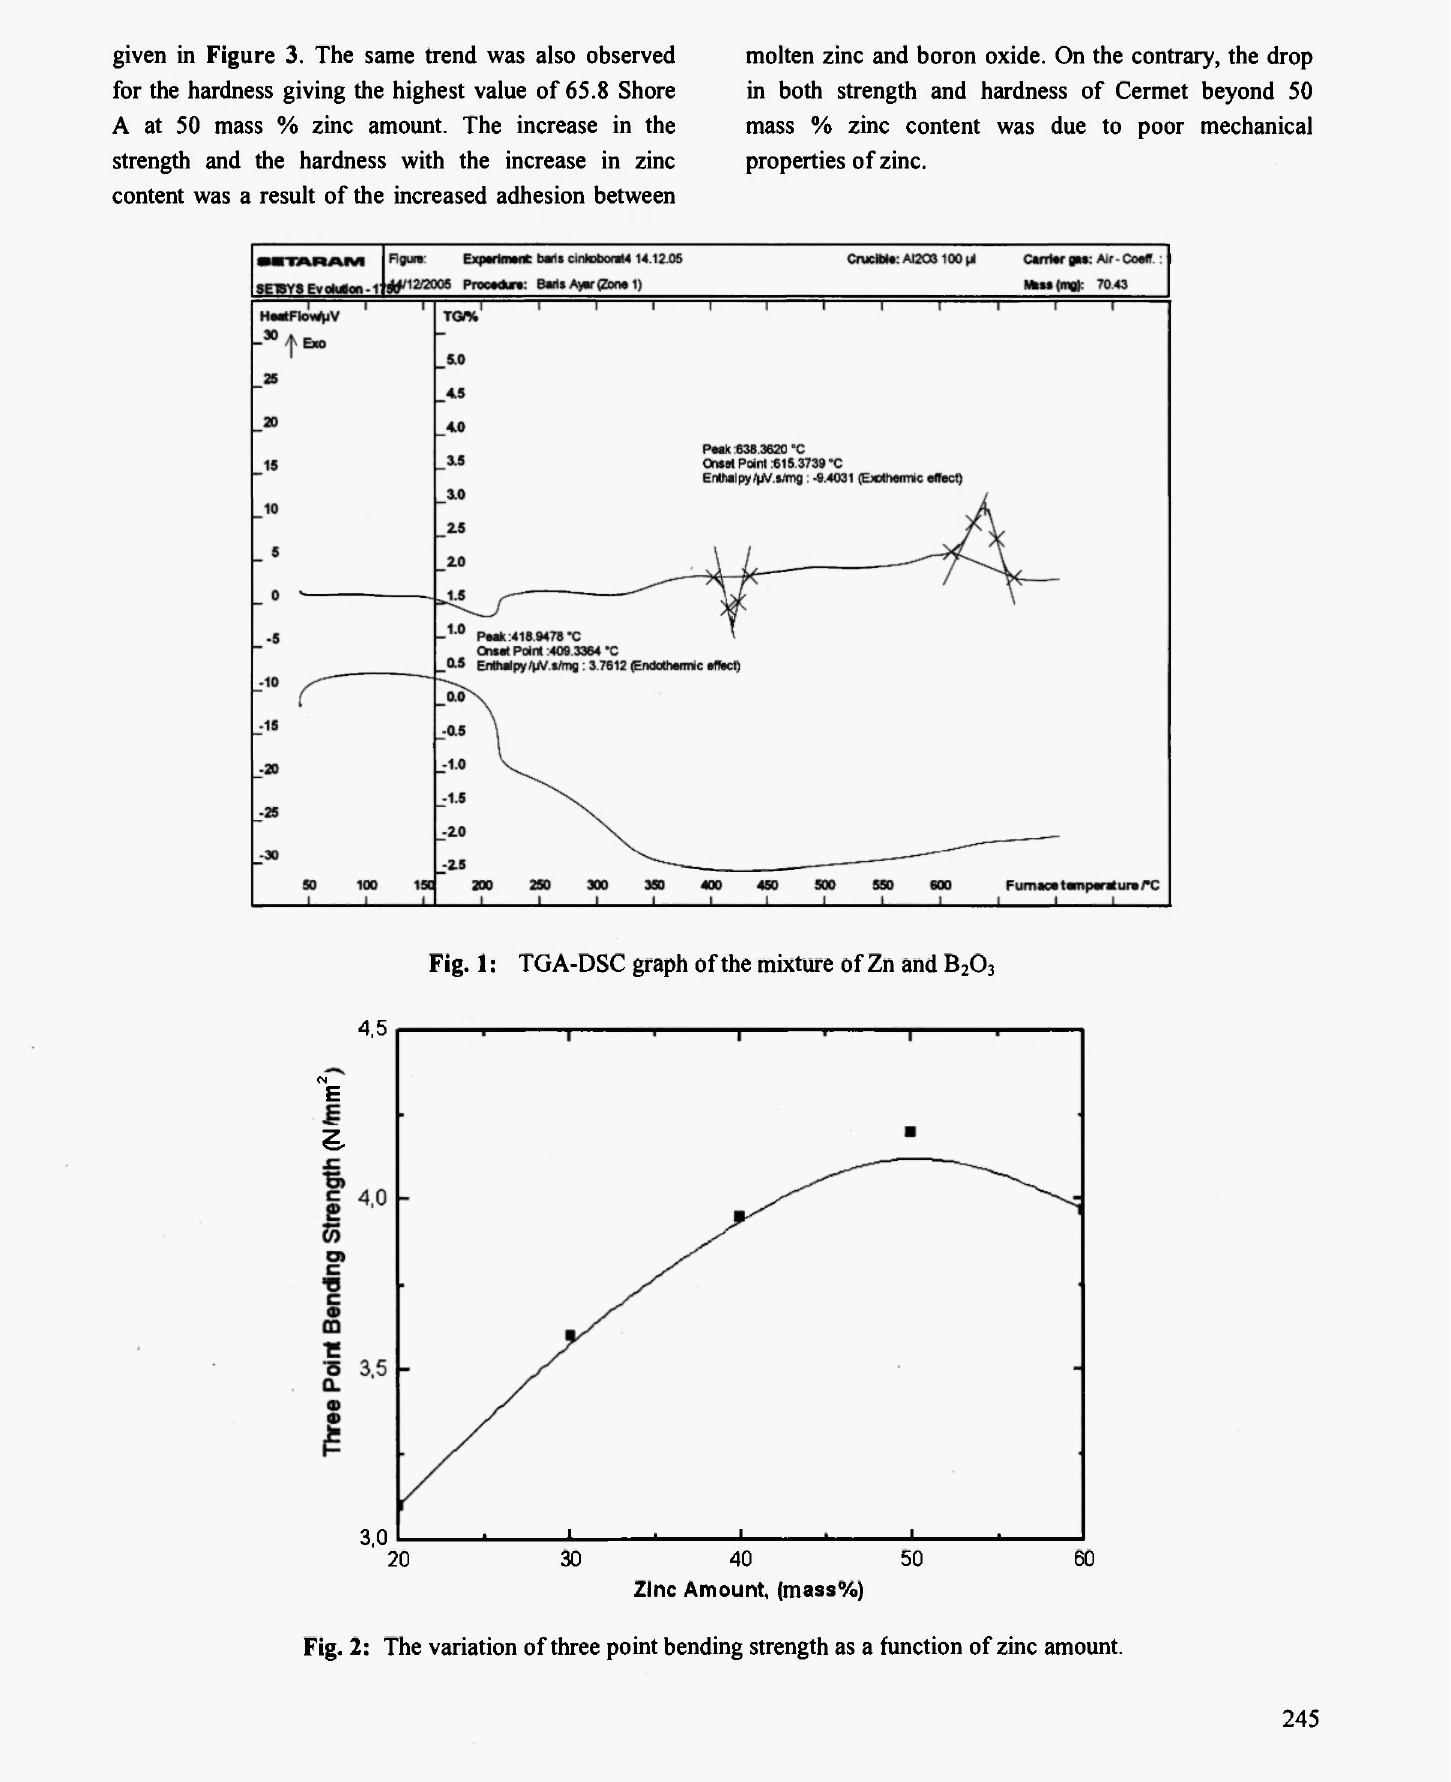
Fig. 2: The variation of three point bending strength as a function of zinc